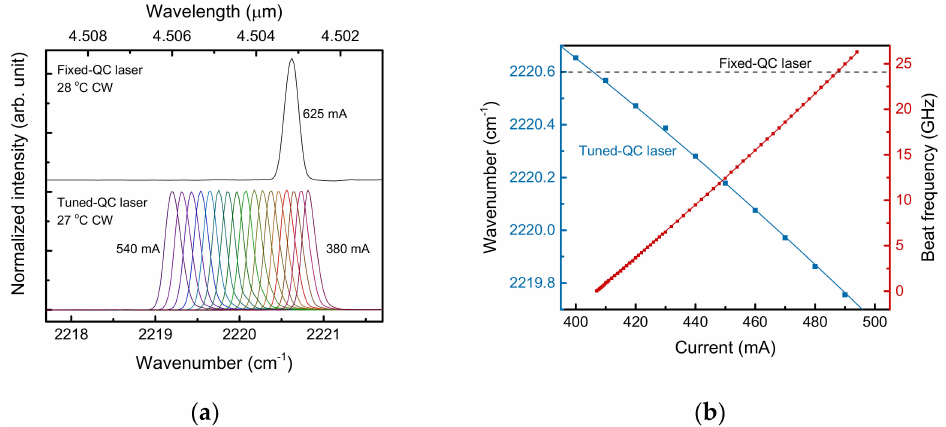
Figure 5. Emission wavelengths of the quantum cascade (QC) lasers and the frequency of the generated beat signal. ( a ) The spectra of the QC lasers depend on the injection current. The upper spectrum corresponds to the fixed QC laser with a fixed current of 625 mA, and the lower spectra correspond to the current-tuned QC laser. ( b ) The beat frequency (red square dots) measured with a QC detector and spectrum analyzer. The red line is a prediction of the beat frequency calculated from the wavelength difference of the fixed (dashed line) and tuned QC lasers (blue square